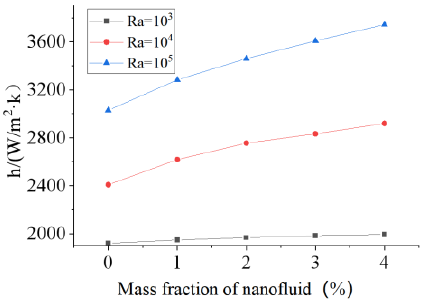
Figure 7. The heat transfer coefficients for various Rayleigh numbers 10 3 , 10 4 and 10 5 , and mass fractions 0–4 wt%. Table 4. The highest temperatures on the wall with heat source for various inlet velocities and heat